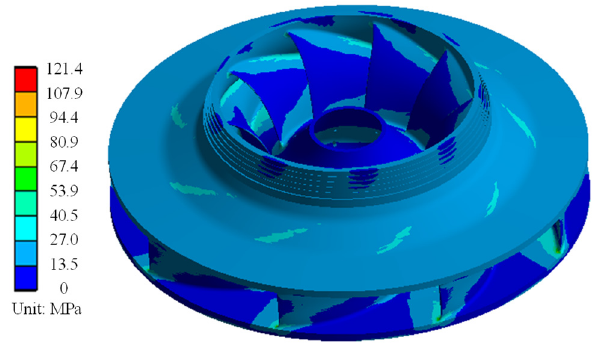
Figure 10. Von-Mises stress on the runner in rated operating condition. The dynamic stresses at the monitoring points are shown in Figure 11. It can be seen that the dynamic stress at the monitoring points is less than 25 MPa. The relationship between dynamic stress and operating head depends on location: the dynamic stresses at P2 and P6 increase with increasing operating head, while the opposite is true for the remaining monitoring points, which is different from the relationship between pressure pulsation and operating head. This is because the dynamic stress at one point of the FEM model is the result of the comprehensive effect of the nearby pressure; the dynamic stress and the pressure pulsation at the same point might show different trends.